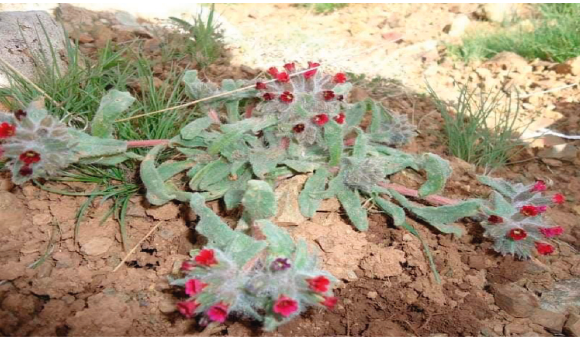
Figure 1: Aerial parts of N.